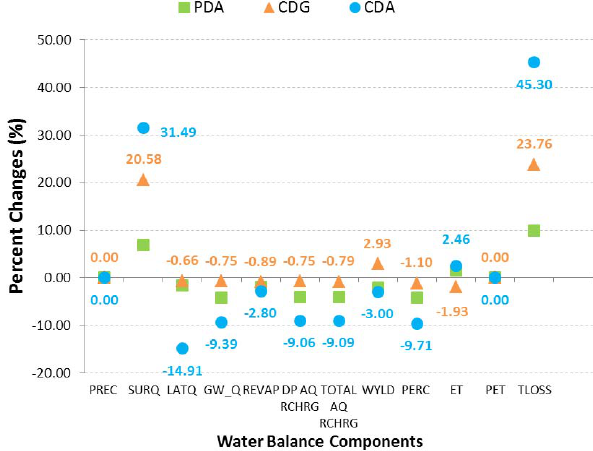
Figure 8. Percent changes in water balance components for simulated land use change scenarios in the Nyangores sub-basin. PDA = Partial Deforestation, conversion to Agriculture, CDG = Complete Deforestation, conversion to Grassland, CDA = Complete Deforestation, conversion to Agriculture.